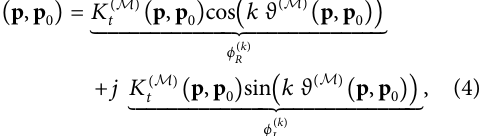
Frontiers in Signal Processing |